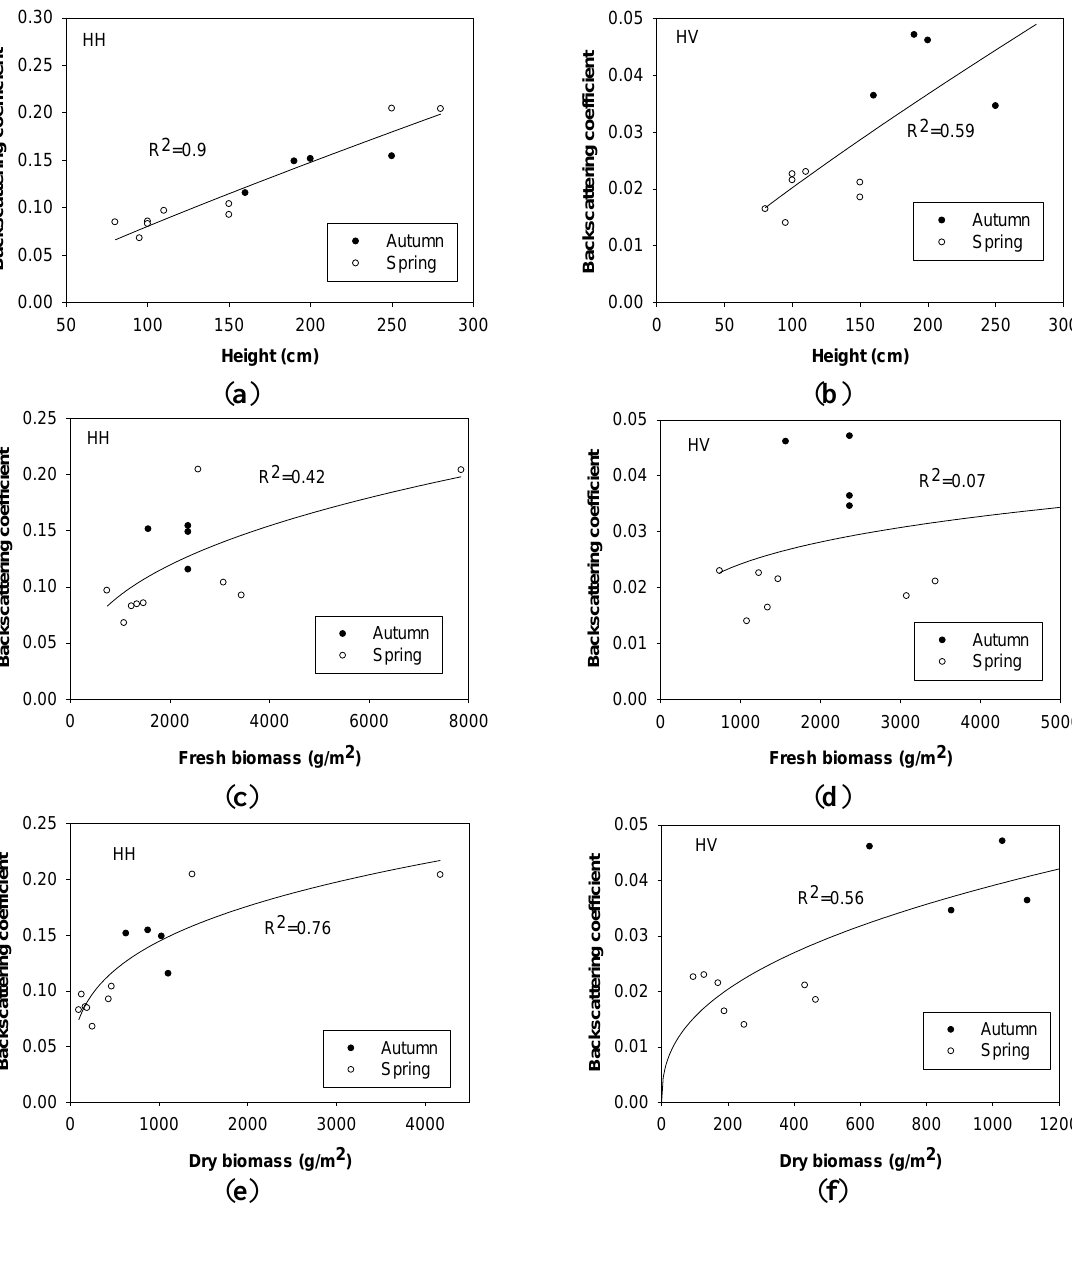
Figure 6. The relationships between ASAR backscattering coefficients in HH polarization and ( left panel ) height, fresh biomass, dry biomass, and vegetation water content; and in HV polarization and ( right panel ) height, fresh biomass, dry biomass, and vegetation water content of Phragmites communis wetland. ( a , b ) height, ( c , d ) fresh biomass, ( e , f ) dry biomass, and ( g , h ) vegetation water